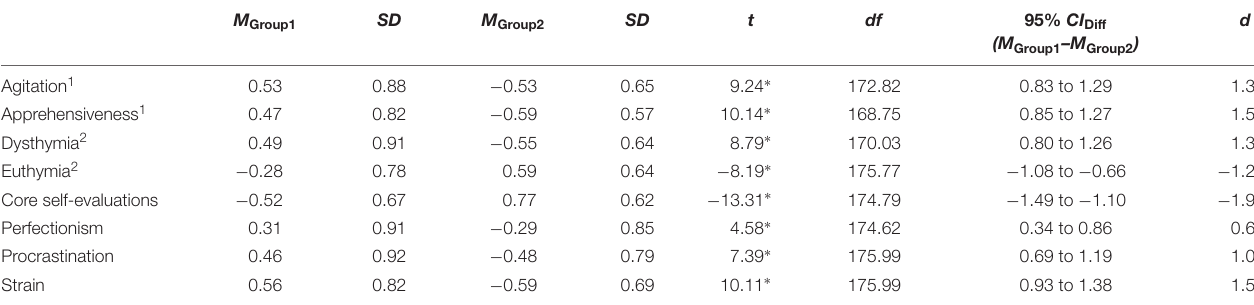
TABLE 1 | Differences in trait levels between the clusters “impostor self-concept” (Cluster 1) and “non-impostor self-concept” (Cluster 2). M